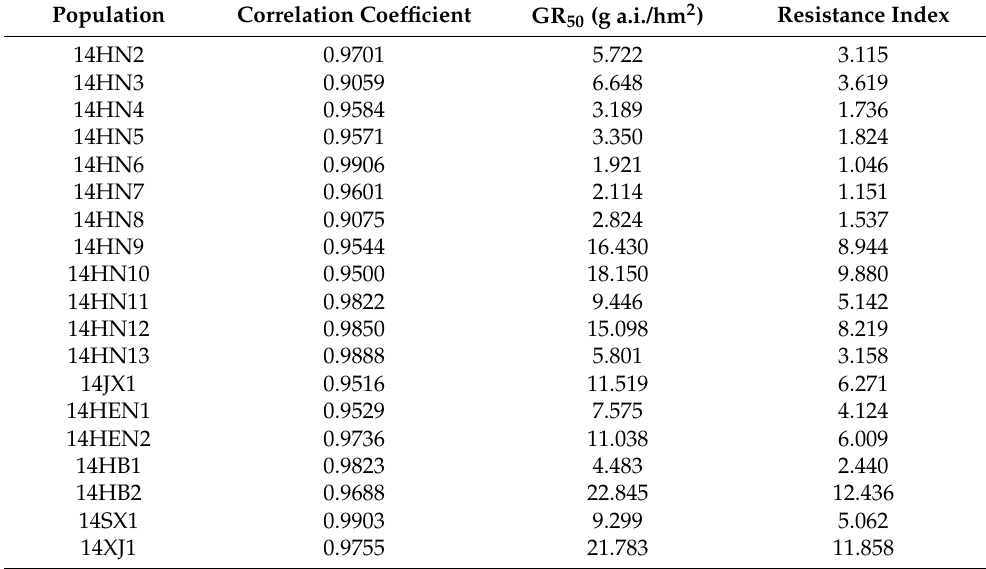
Table 1. The different resistance levels of D. sanguinalis populations to haloxyfop-P-methyl in cotton fields